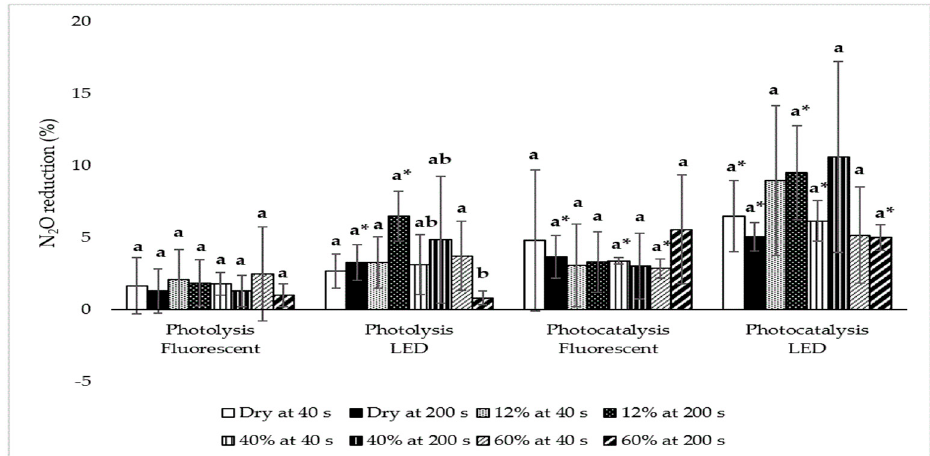
Figure 13. Comparison of N 2 O mitigation under di ff erent relative humidity and treatment time. Superscript (*) signifies a statistical di ff erence compared to the control ( p < 0.05), and the di ff erent characters (a, b) signify the statistical di ff erence between treatments associated with one UV lamp type ( p < 0.05). Error bars signify ± standard deviation.